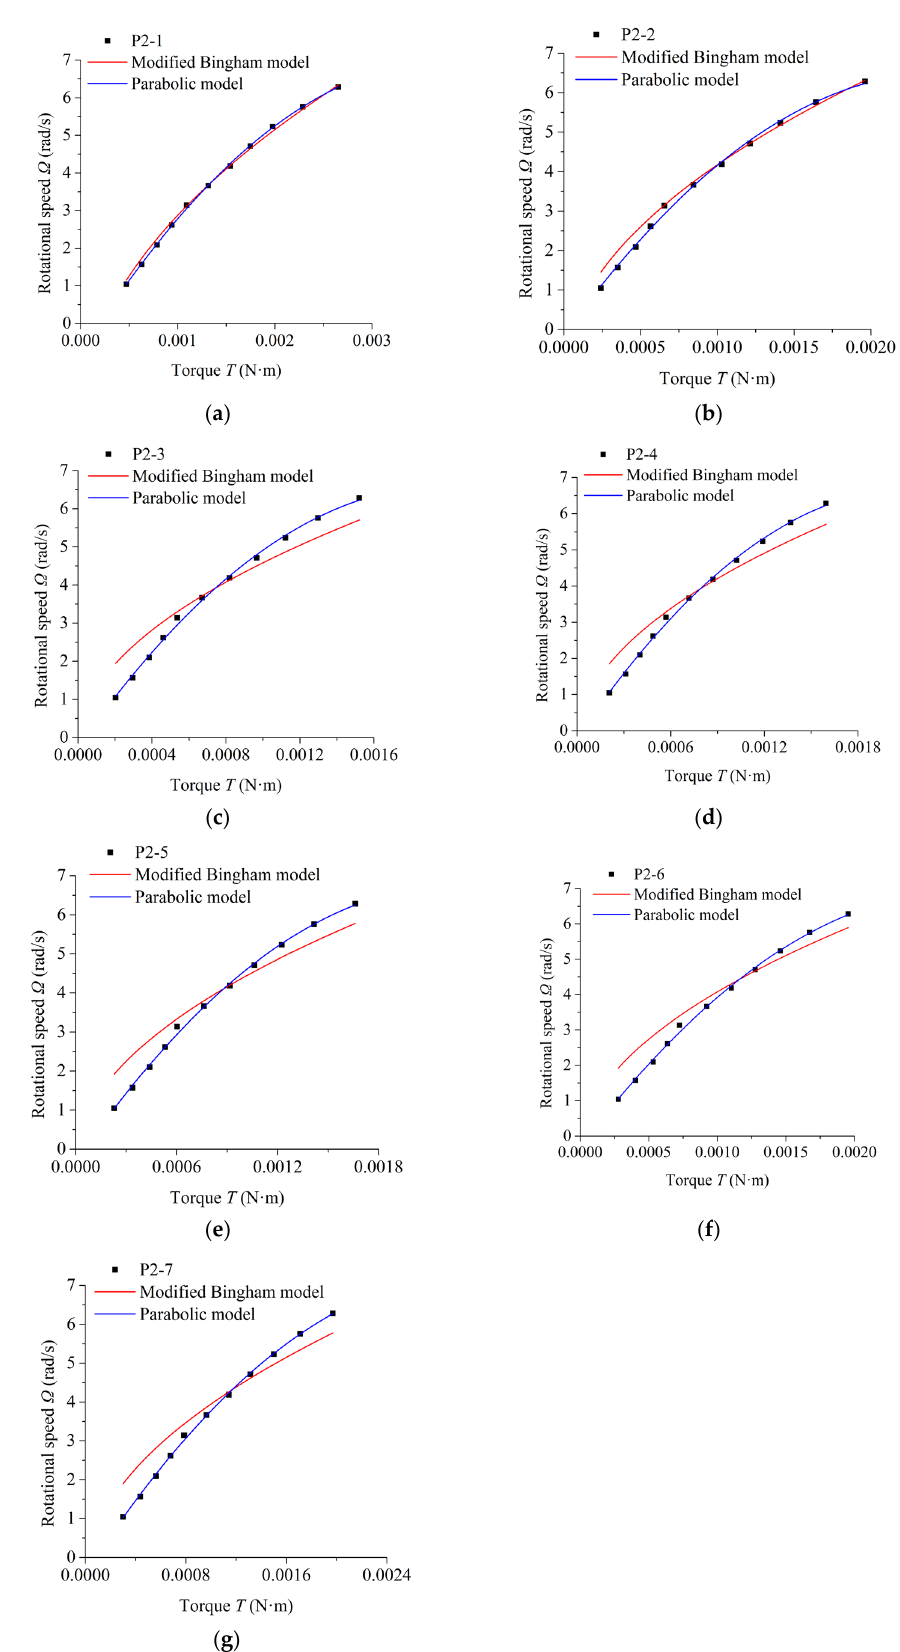
Table 4. Fitting data of P2 based on modified Bingham model and parabolic model.